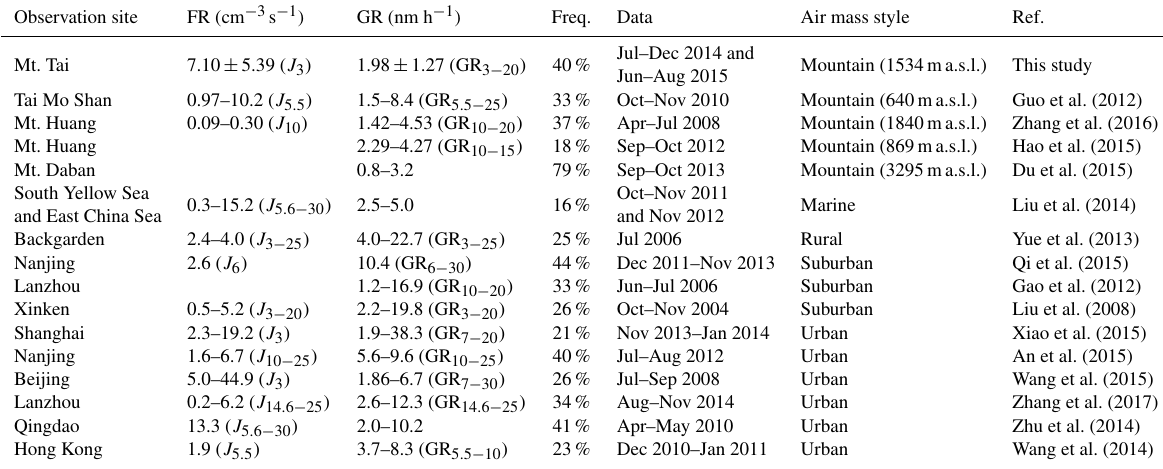
Table 3. Comparison of NPF characteristics between Mt. Tai and other studies in China. Observation